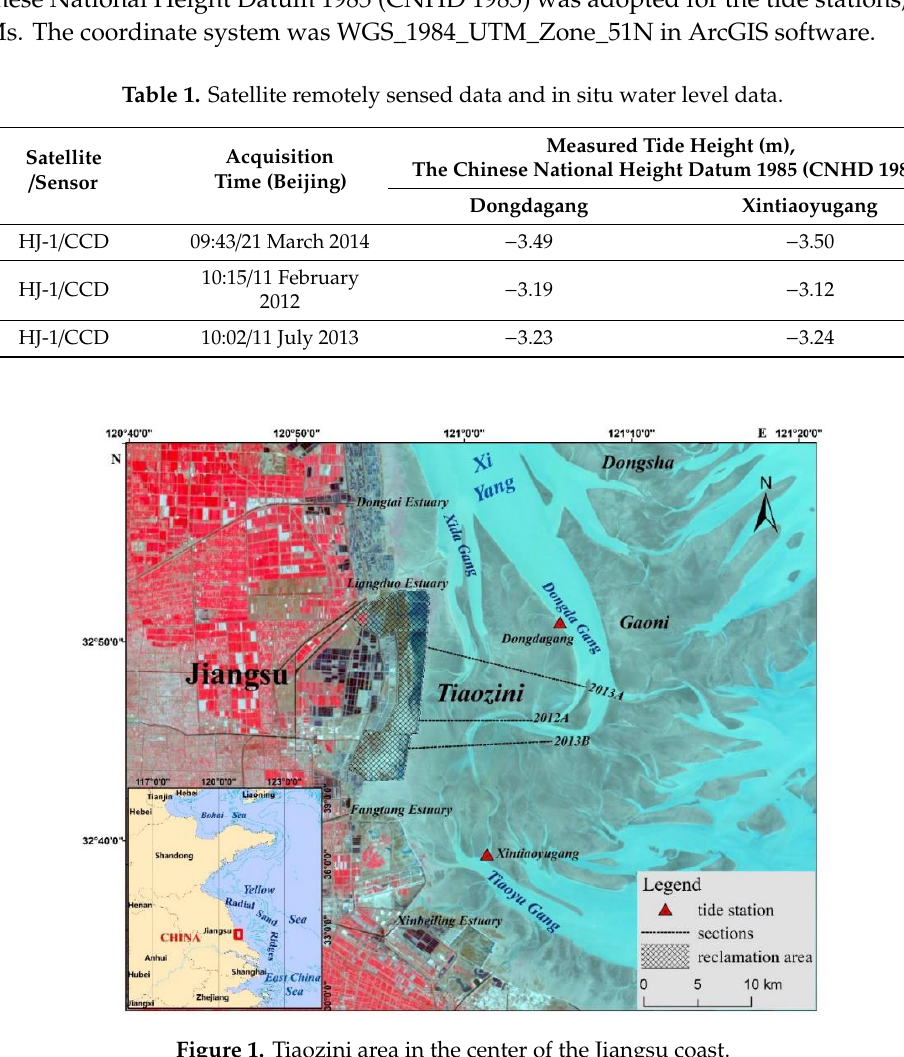
Figure 1. Tiaozini area in the center of the Jiangsu coast.